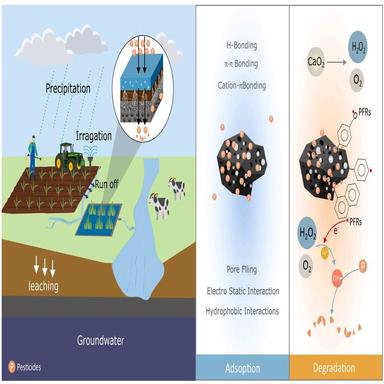
The conceptual diagram for using CaO2-coated biochar as a catalytical intensified CWs substrate material for pesticide mitigation for agricultural drainage. The agricultural runoff can be collected to the constructed wetlands and the pesticides can be captured by adsorption and followed by AOPs degradation by hydroxyl radicals produced by BC/CaO2. The pesticides fragments will be further mineralized by interacting with plants roots and microbes in CWs.